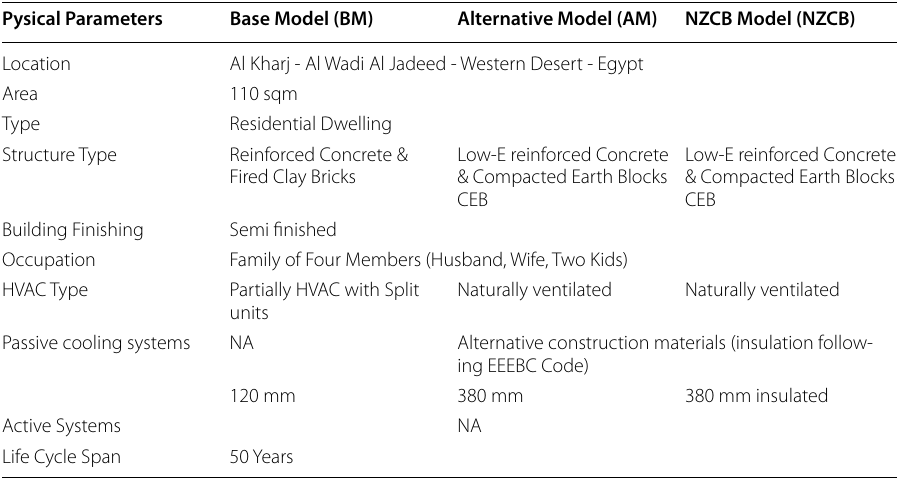
Table 2 Experimental models information